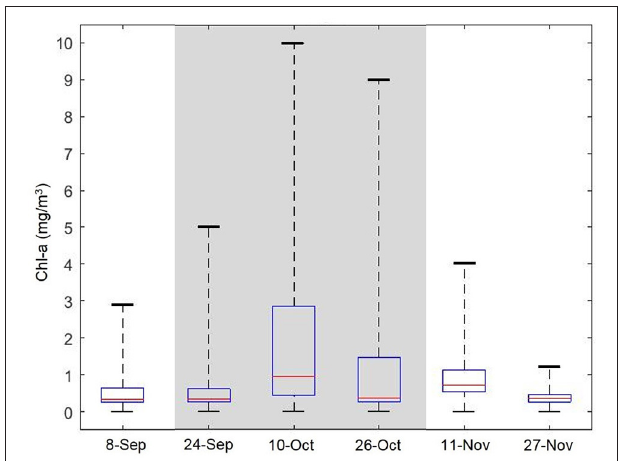
FIGURE 9 | OLI-derived chl-a concentration range in the region-of-interest for each date of the time series shown in Figure 7 . Prior to the diversion, chl-a levels were relatively low with low variability within the ROI. During the diversion, gray region, chl-a levels increased well above nominal values. Post-diversion, chl-a values returned to nominal